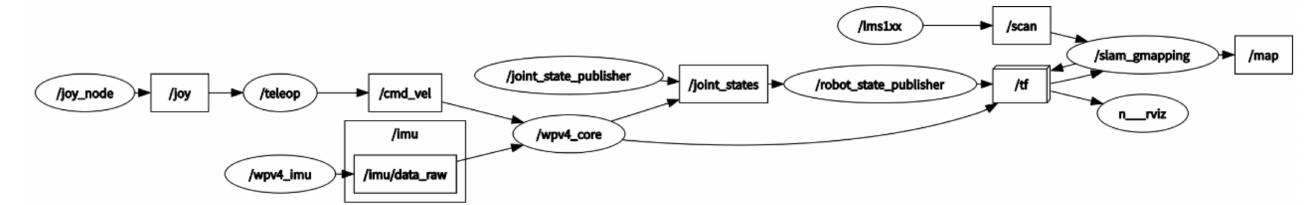
Figure 10. SLAM-gmapping subscription and publishing flow